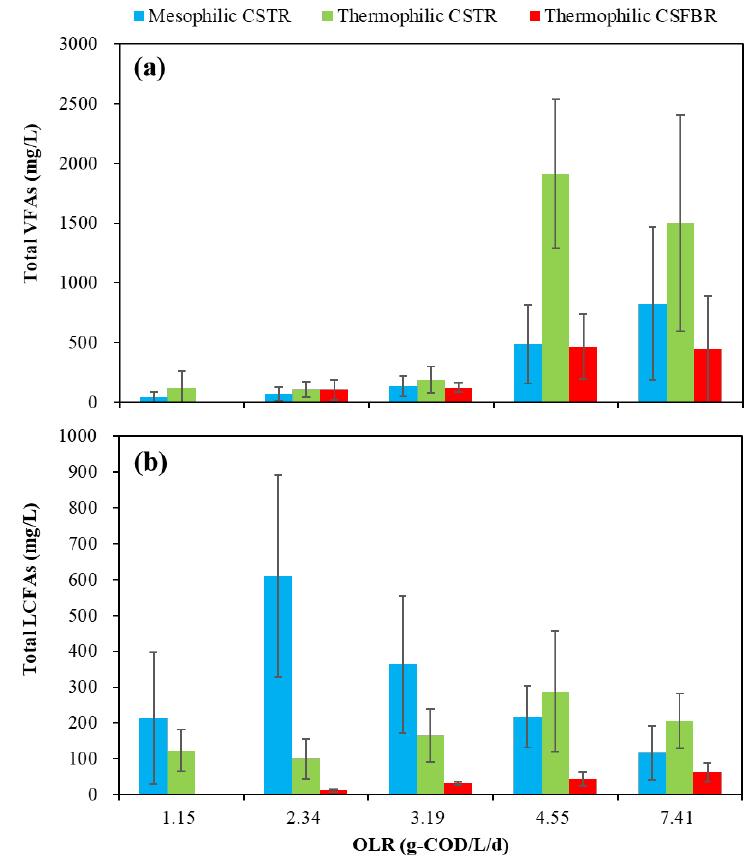
Figure 4. Effects of OLRs on the VFAs and LCFAs production.